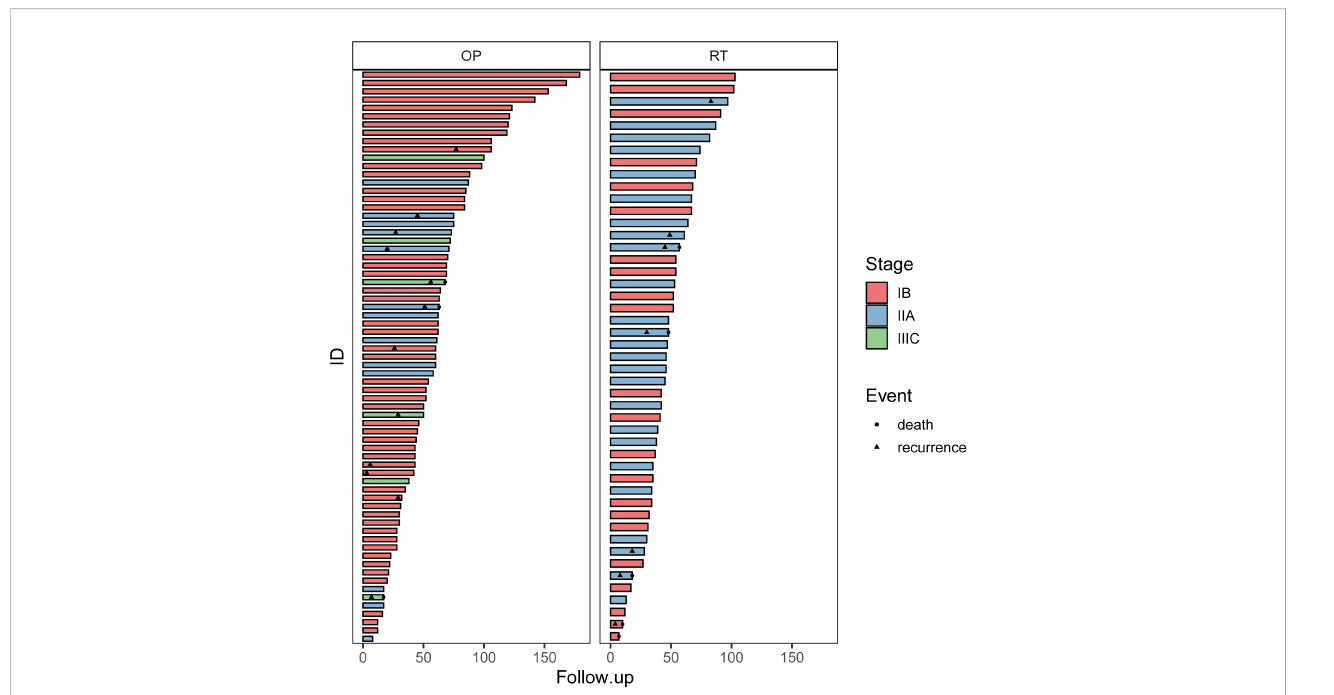
FIGURE 2 The swimmer plots of patients in the OP and RT groups. OP, operation group; RT, radiotherapy